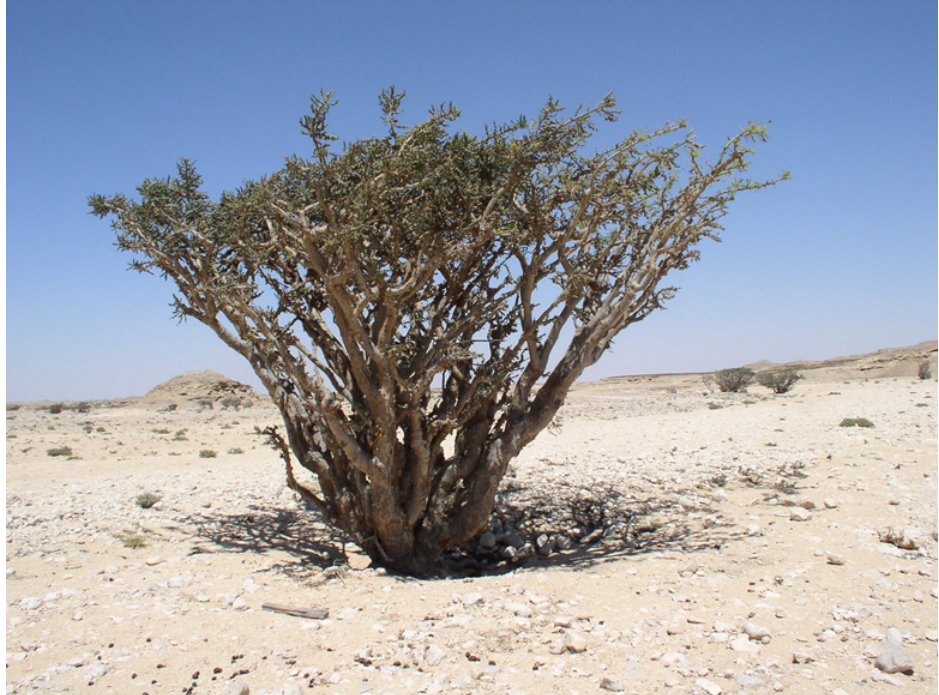
Figure 1. Boswellia sacra in Wadi Dawkah, a natural park of frankincense-producing trees in Oman. Boswellia sacra photo from Wikimedia.org.